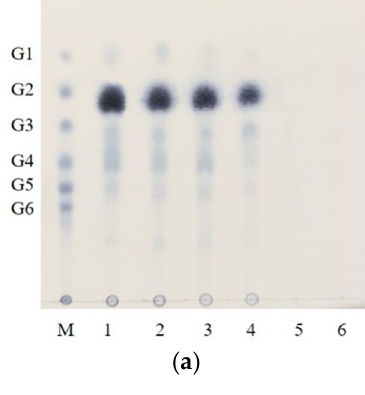
Figure 9. Determination of n Ta AA9A thermostability. ( a ) TLC analysis of n Ta AA9A reaction products. n Ta AA9A was initially treated for 30 min at 50, 60, 70, 80, 90, and 100 °C (lanes 1–6, respectively; M: standard cello-oligosaccharides) in 10 mM NH 4 OAc–HOAc (pH 5.0) without substrate. The treated n Ta AA9A was incubated with 0.5% PASC in 10 mM HOAc–NH 4 OAc (pH 5.0) and 1 mM ascorbate at 50 °C for 48 h. ( b ) Residual activity of n Ta AA9A as a percentage of the maximum activity (100%). The residual n Ta AA9A activities were measured using HPLC–RID by detecting gluconic acid in n Ta AA9A reaction products after their hydrolysis with TFA. The experiment was carried out in triplicates.